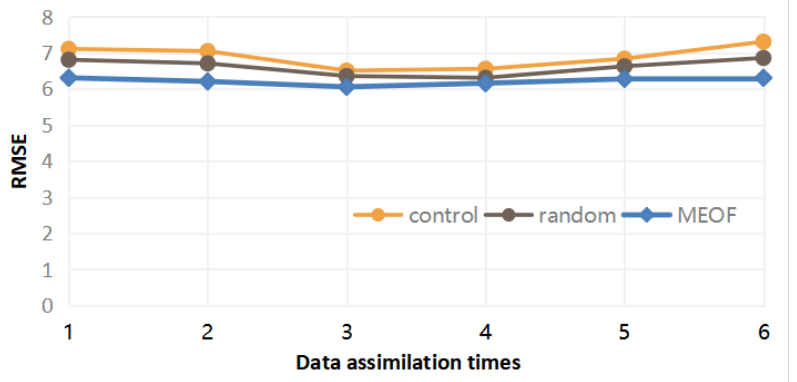
Figure 11. The RMSE of the LETKF data assimilation results compared with the observation data for the surface